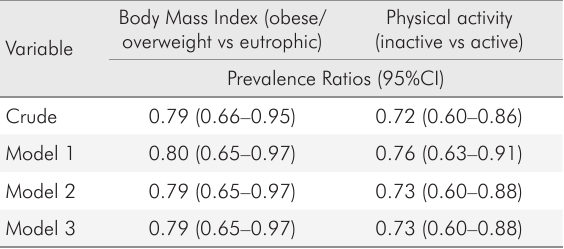
Model 1: Adjusted for socioeconomic variables (type of school, family income and mother’s education); Model 2: Adjusted for Model 1 + demographic variable (sex and age); Model 3: Adjusted for Model 2 + oral health variable [(Gingival inflammation (Bleeding sites)] +